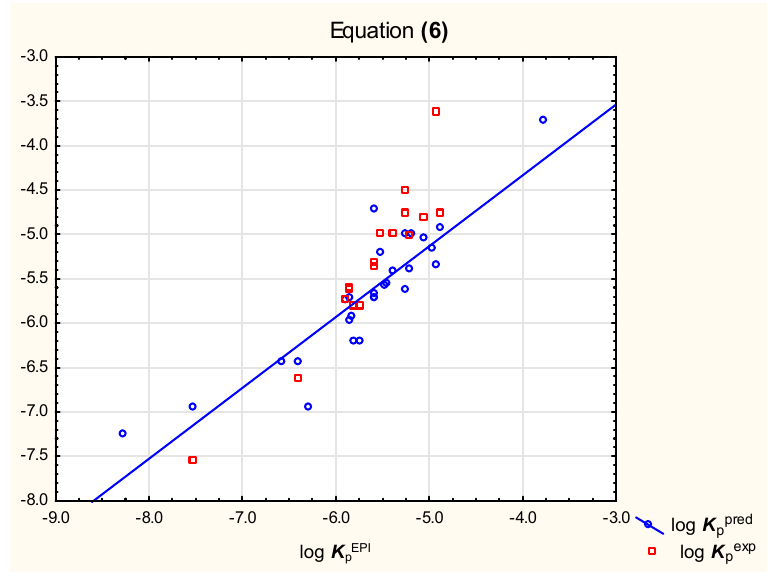
Figure 1. Equation (6)—predicted and experimental log K p vs. reference values.